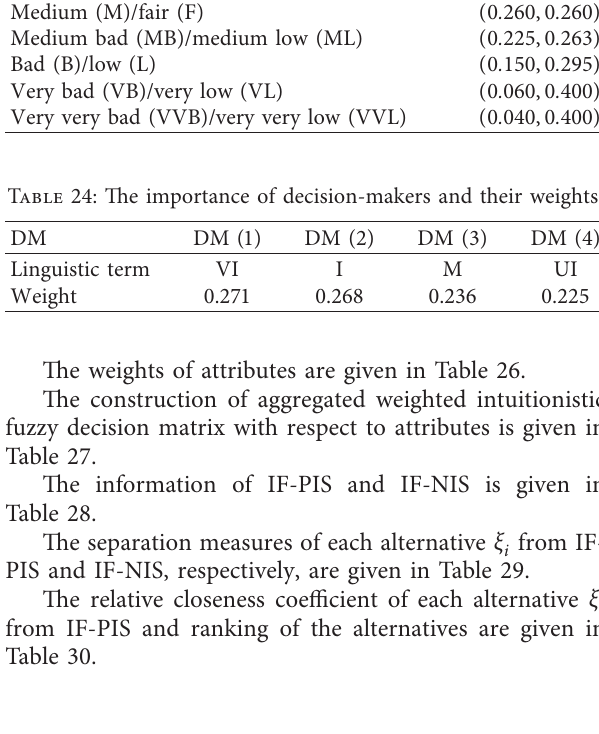
Table 26: The weights of attributes. Attributes